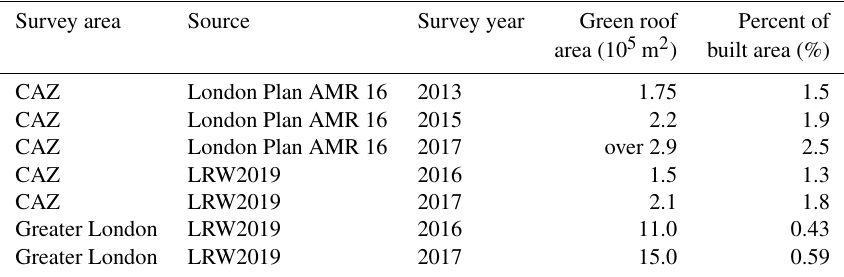
Table 1. Previous estimates of green roof area in London. CAZ refers to a central area of London; see Sect. 2.1. Data are from Grant and Gedge (2019) and Greater London Authority